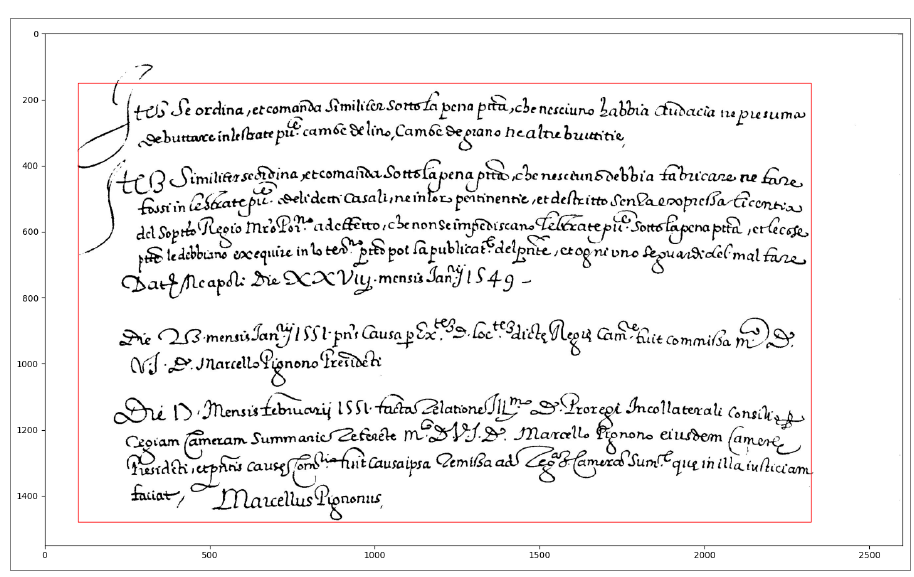
Figure 3. Examples text area detection: the figure shows in the red rectangle the text area detected in a document